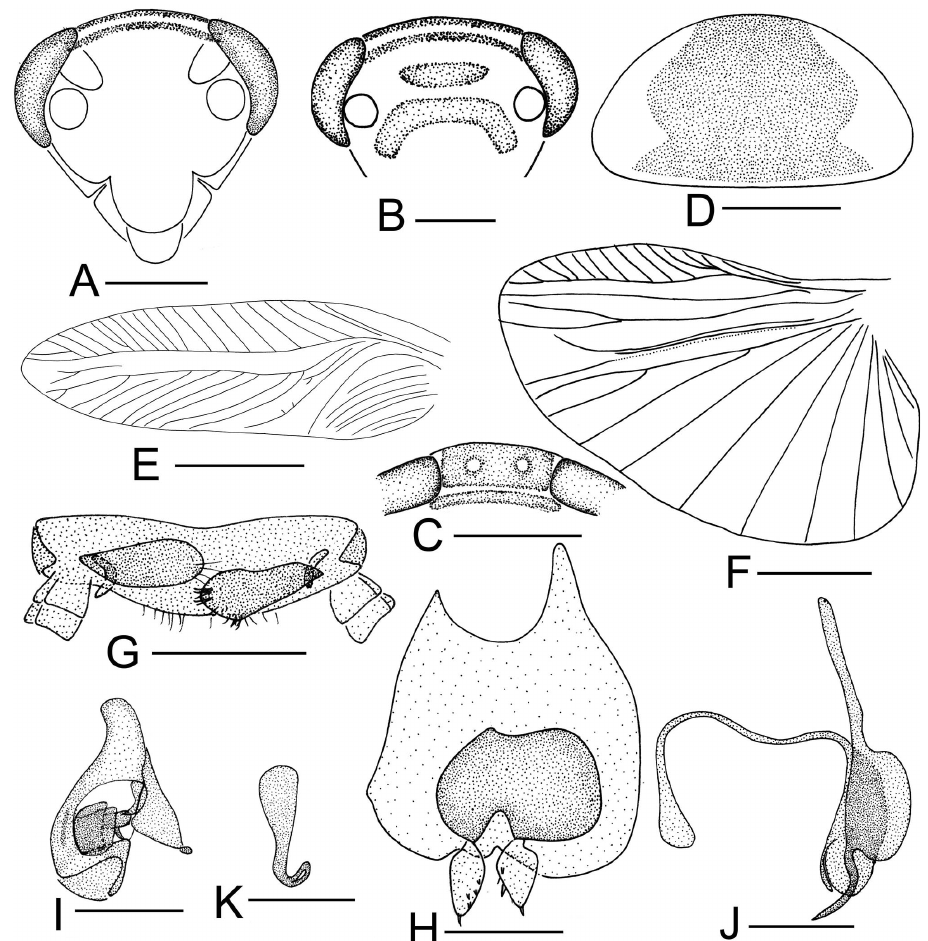
Figure 7. Sorineuchora bimaculata sp. n. A Paratype, male from China, Chongqing, Wulong, Wanfeng B–K Holotype A–B heads, frontal view C vertex D pronotum E tegmen F hind wing (the dotted line in- dicates wing fold) G supra-anal plate, ventral view H subgenital plate, dorsal view I phallomere L1 J phal- lomere L2vm and R3 K phallomere R2. Scale bars: 0.5 mm ( A–C, G–K ), 1.0 mm ( D ), 2.0 mm ( E, F ). margin, the interstylar margin slightly concave (Fig. 7H). L1 consisting of several ir- regular seta-free sclerites (Fig. 7I); middle of L2vm inflated, pre-apex curved and apex acute; R3 arched and filament, the apex inflated (Fig. 7J); hooked phallomere (R2) on the right side, with a preapical